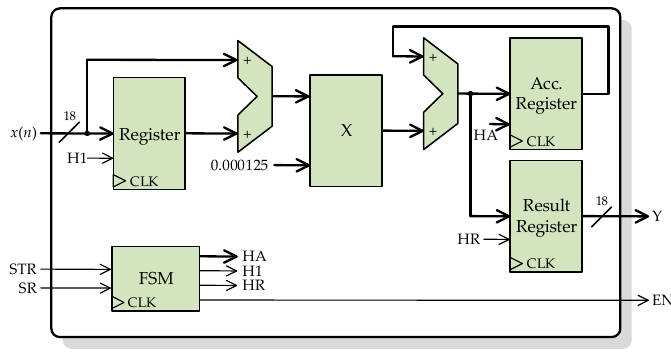
Figure 10. Architecture of the processing core for computing the integral.